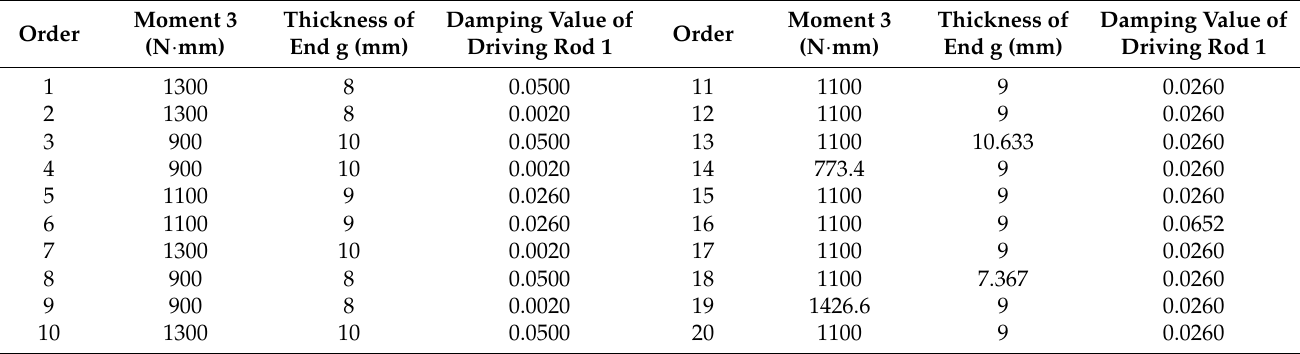
Table 8. Synthesis center composite design test data design